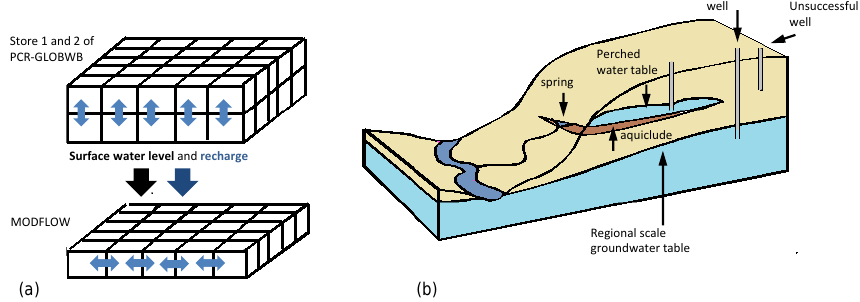
Figure 1. (a) Model structure used to couple the land-surface model PCR-GLOBWB with the groundwater model MODFLOW: first average annual net recharge and average annual channel discharge is calculated with PCR-GLOBWB. The latter is translated into surface water levels. Both recharge and surface water levels are used to force MODFLOW (Sutanudjaja et al., 2011). (b) Cross section illustrating the difference between the simulated regional-scale groundwater level and the perched groundwater levels that are often sampled.